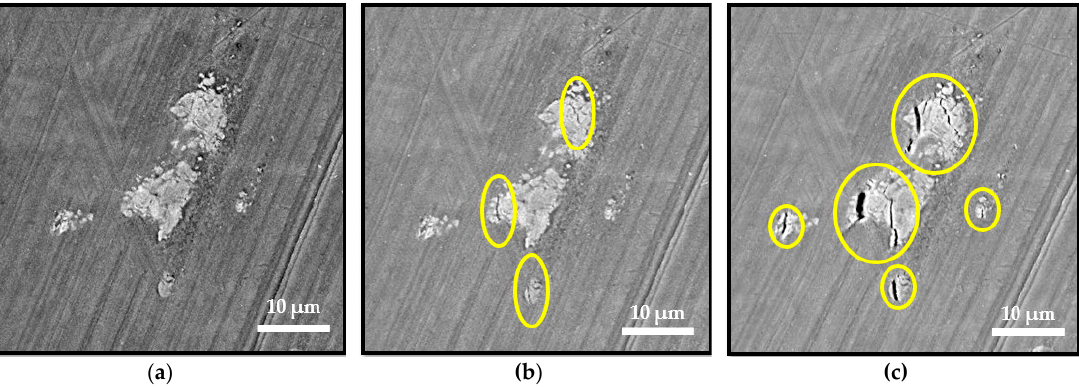
Figure 21. Observation of particle cracking: ( a ) Intermetallic particle before tensile loading; ( b ) Intermetallic particle at yield strength (415–419 MPa); ( c ) Intermetallic particle at tensile strength limit (484 MPa). The loading axis was horizontal.